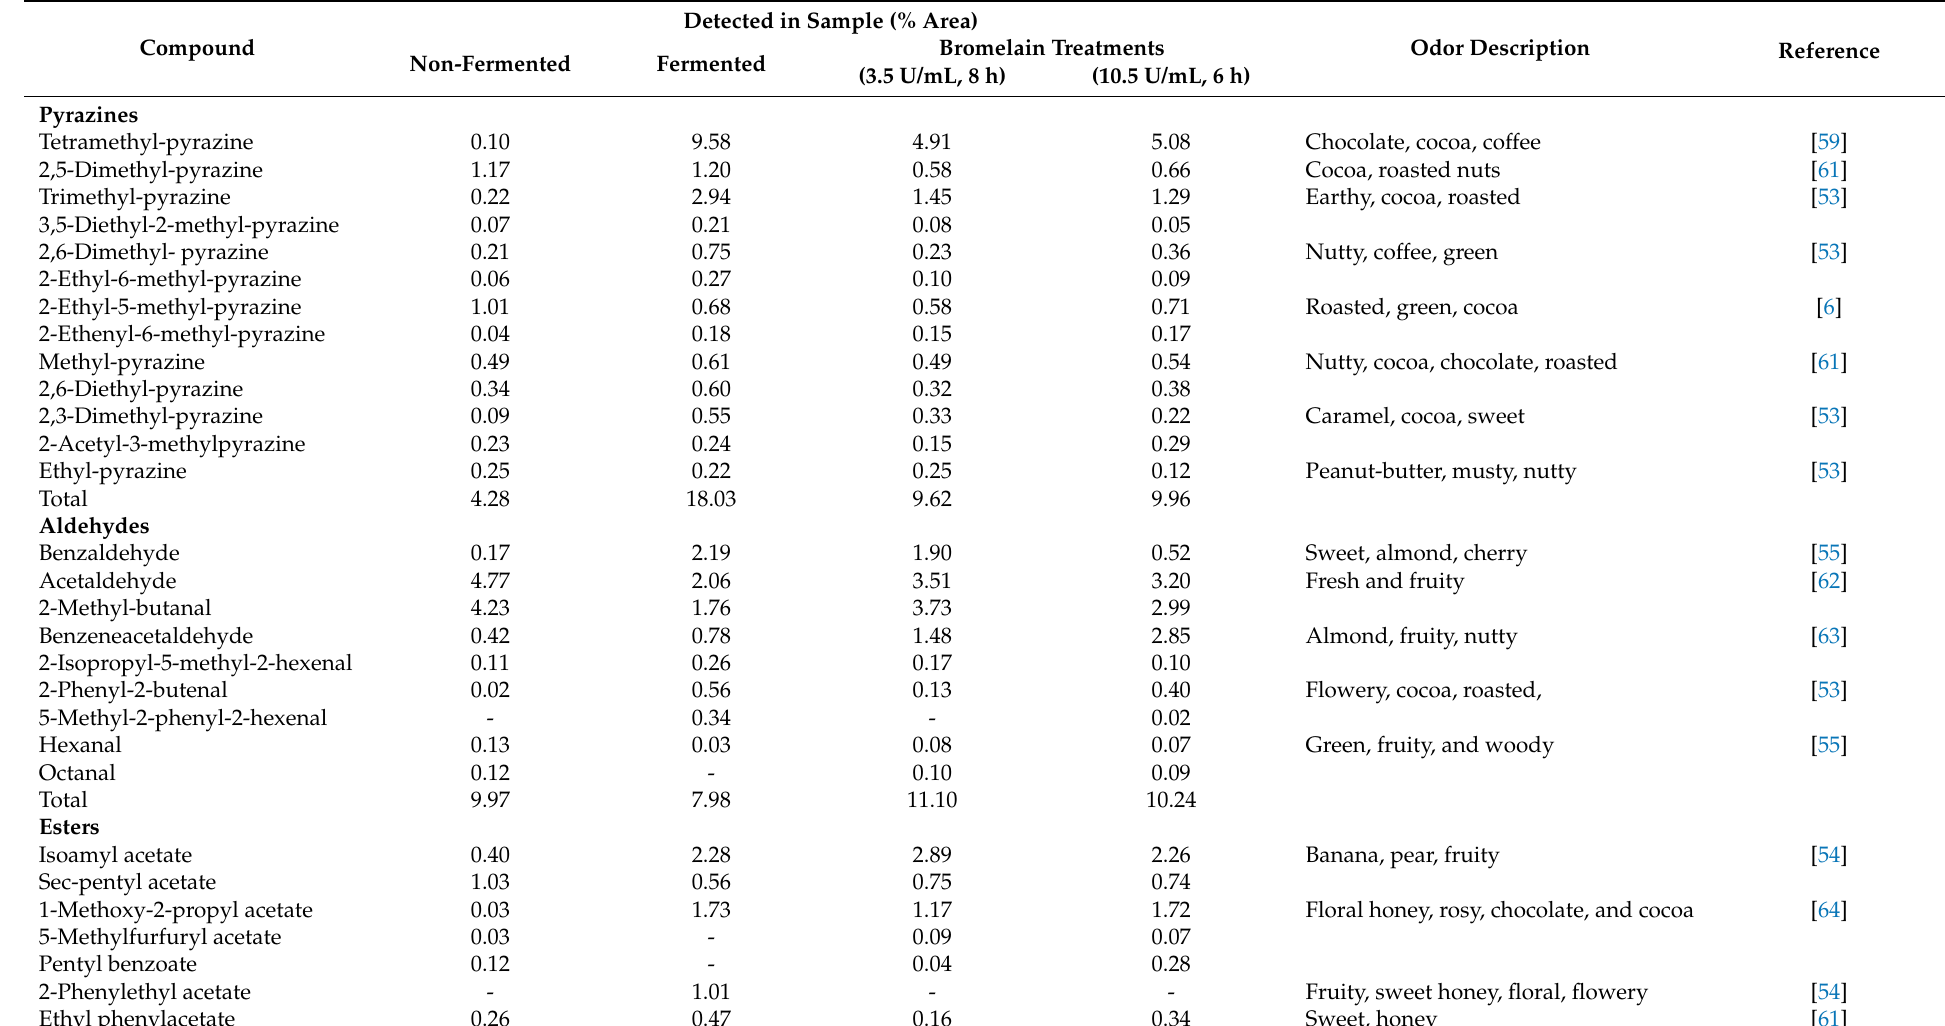
Table 4. Volatile compounds of cocoa beans hydrolyzed by